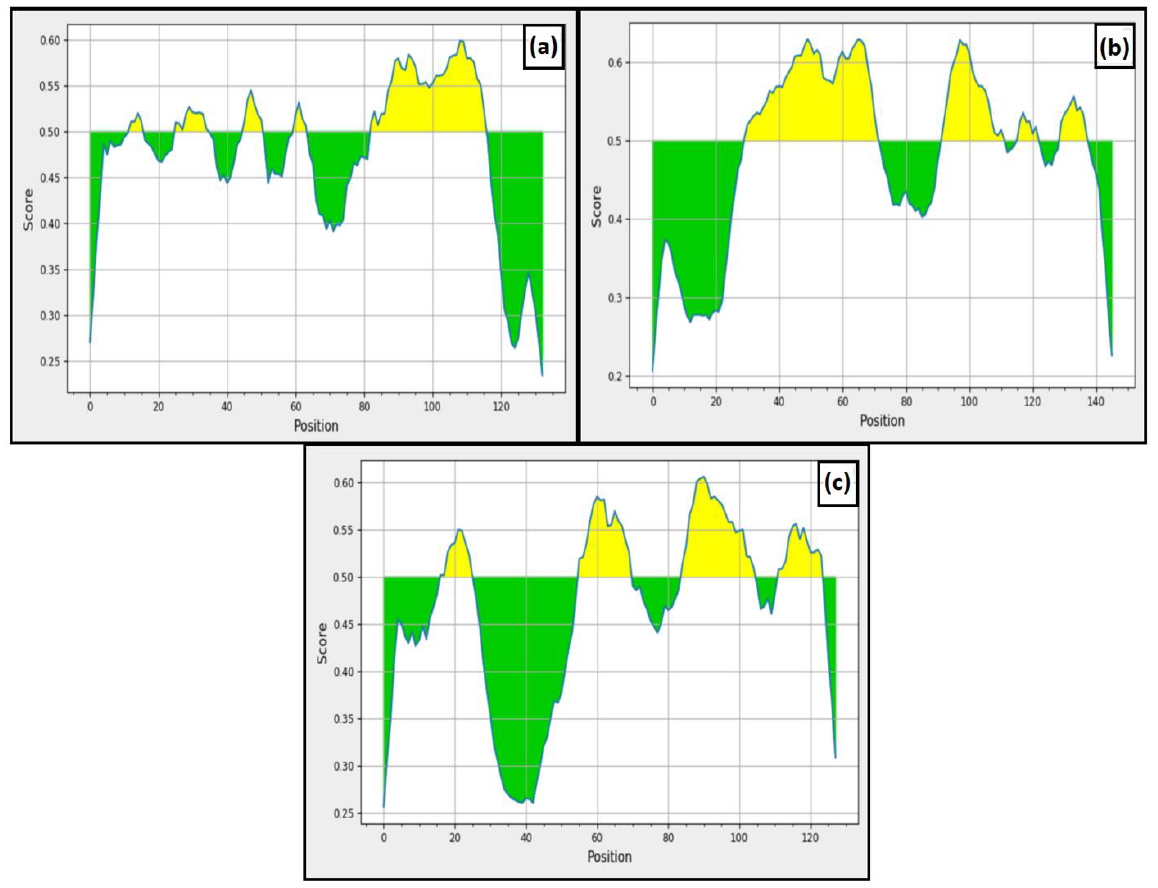
Figure 3. BepiPred linear epitope prediction ( a ) L5L, ( b ) A28, and ( c ) L5.